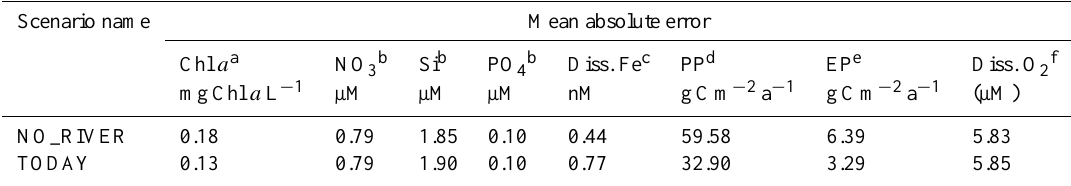
Table 2. Mean absolute error (MAE) between PISCES-T simulations NO_RIVER and TODAY (average 1998–2005) and available data